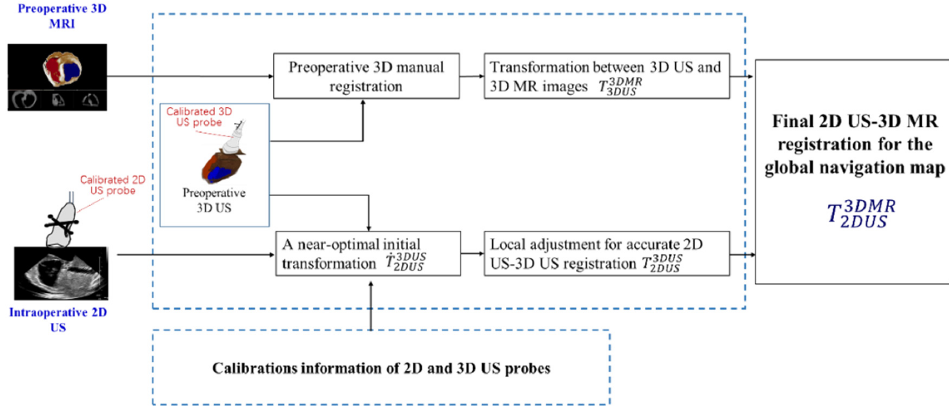
Figure 2. 2D (two ‐ dimensional) US ‐ 3D (three ‐ dimensional) MR images registration based on Figure 2. 2D (two-dimensional) US-3D (three-dimensional) MR images registration based on calibrations information of 2D and 3D US probes. calibrations information of 2D and 3D US probes.